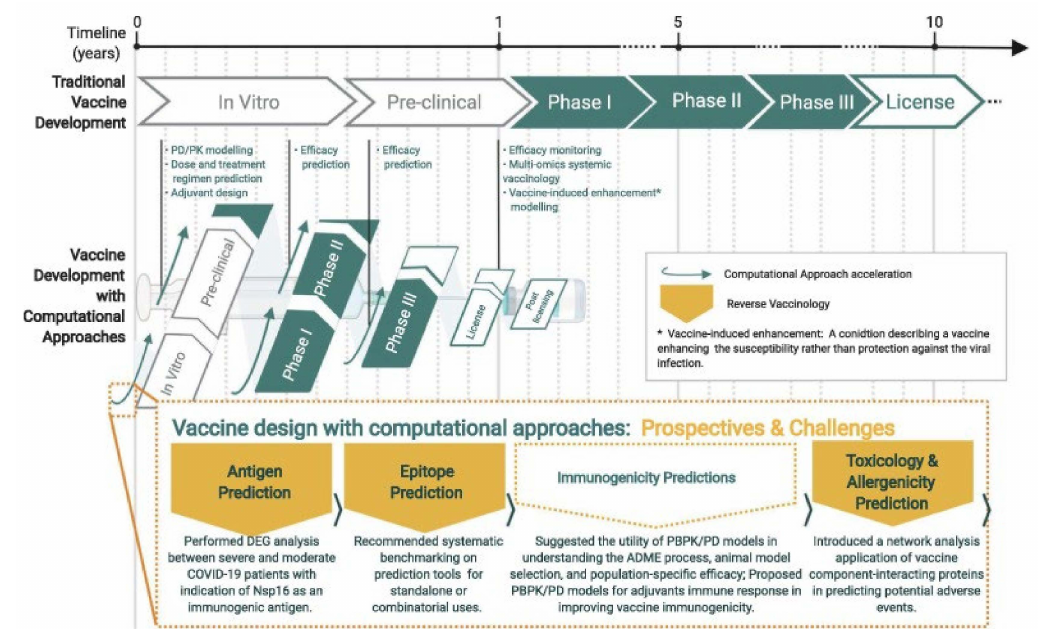
Figure 14. Computational tools can accelerate the development of vaccines at various stages. The center of the diagram shows what role computational models can play at each stage of vaccine development. Reproduced with permission from [291]. Copyright Elsevier,